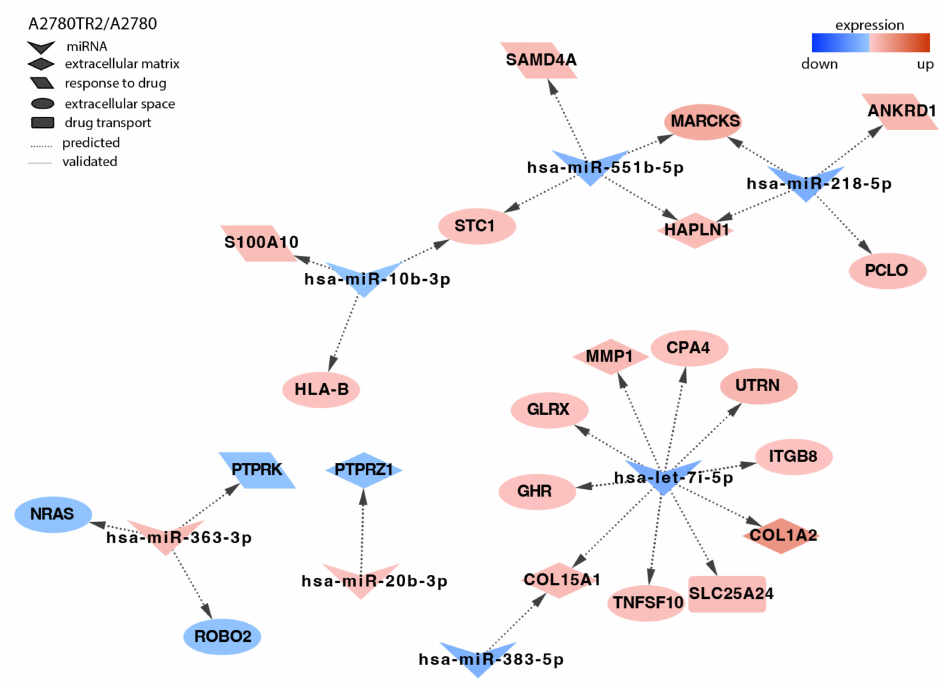
Figure 6. Regulation of selected target genes by miRNAs in the A2780TR2 cell